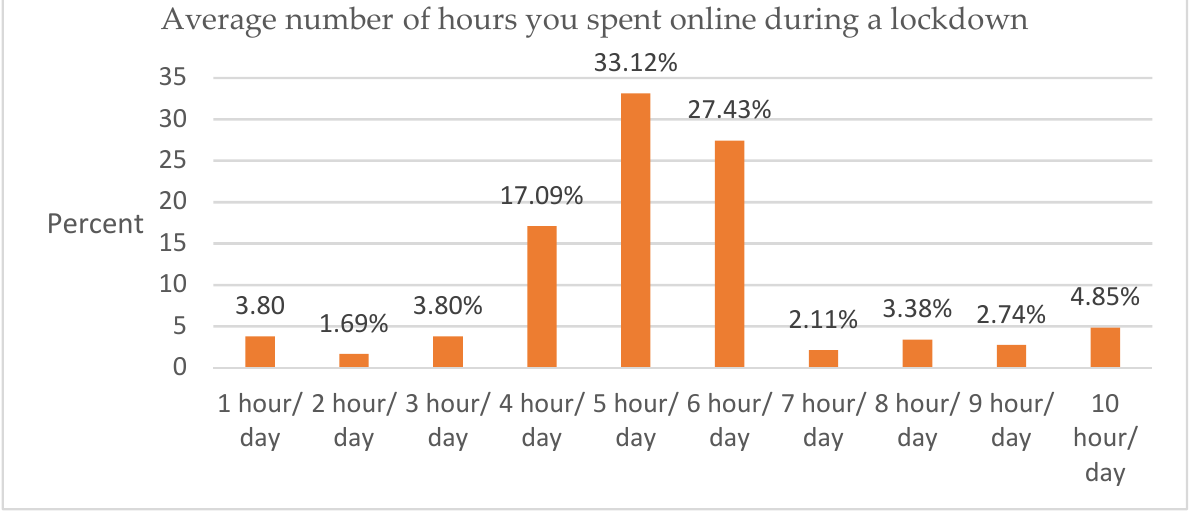
Figure 3. Average number of hours you spent online during a lockdown .